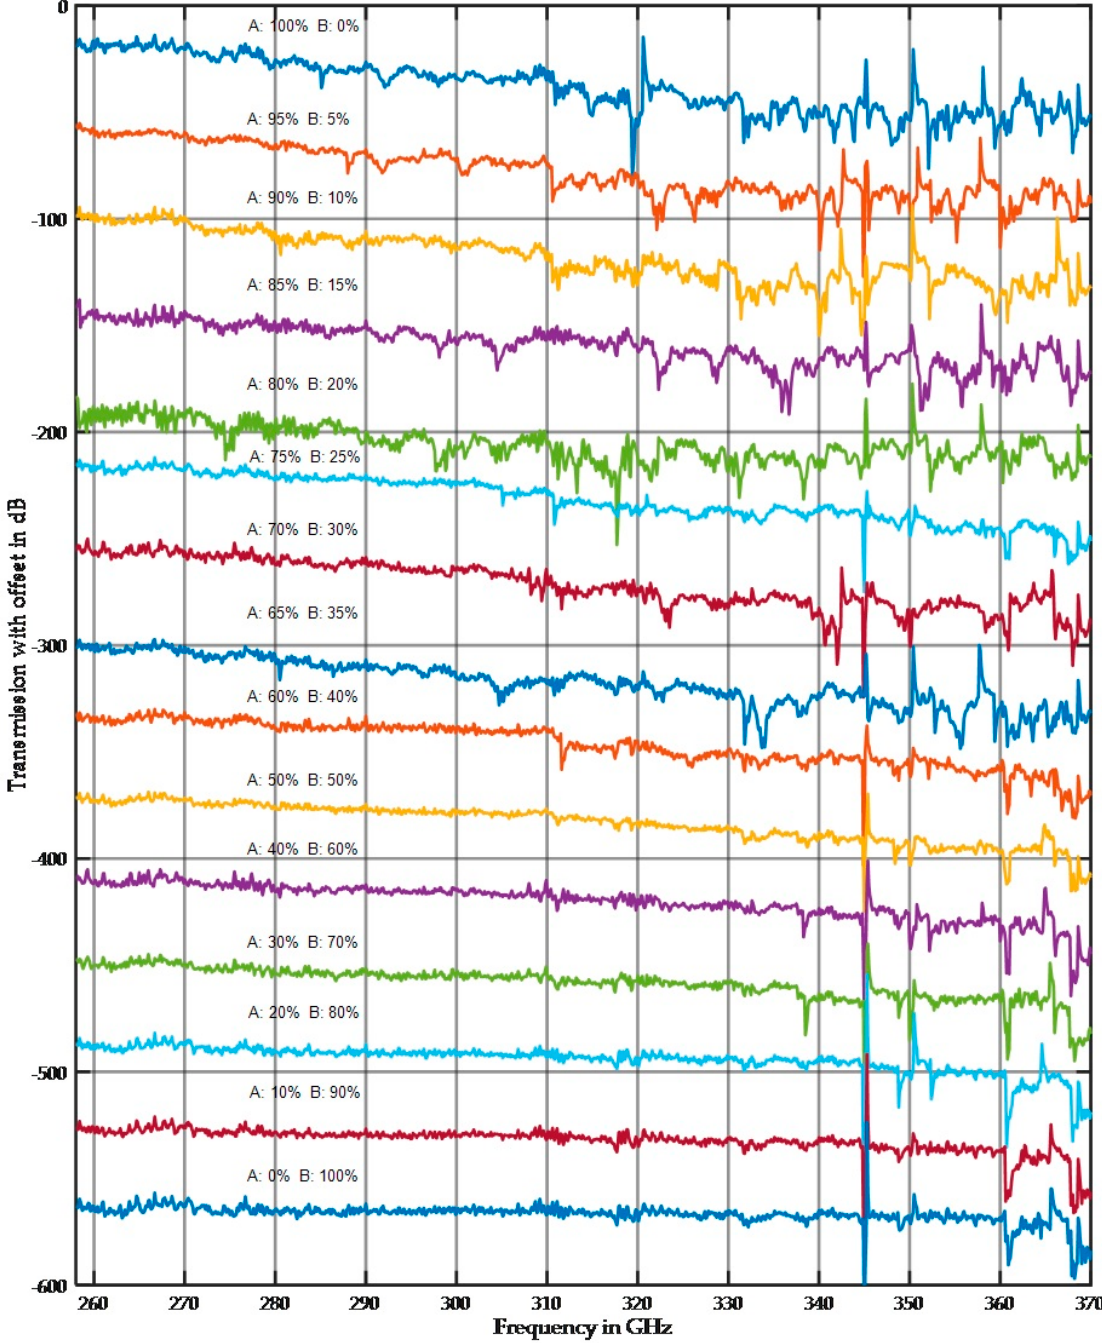
Figure 16. Measurement of the same mixed fractions at different positions. Fraction A is a 0.4–0.5 mm fraction, and fraction B is a 63–100 µm fraction. The percent composition is indicated in the figure. Selected spectra were plotted.